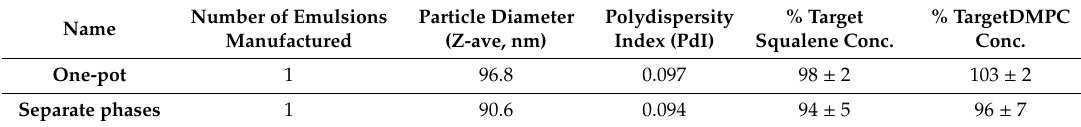
Table 5. Pilot scale (10 L) production of 30% v / v SE using one-pot or separate phase